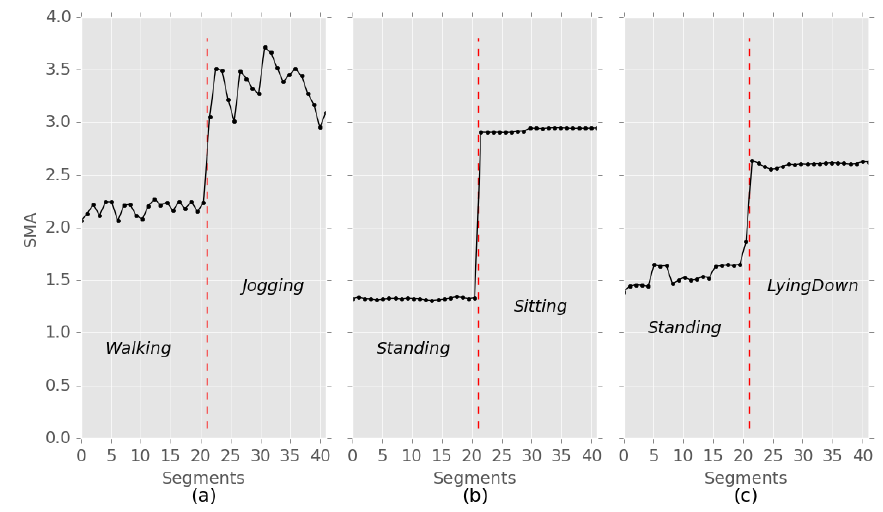
Figure 2. SMA according to the activity changes of three subjects. Activity transition from ( a ) walking to jogging, ( b ) standing to sitting, and ( c ) standing to lying down.